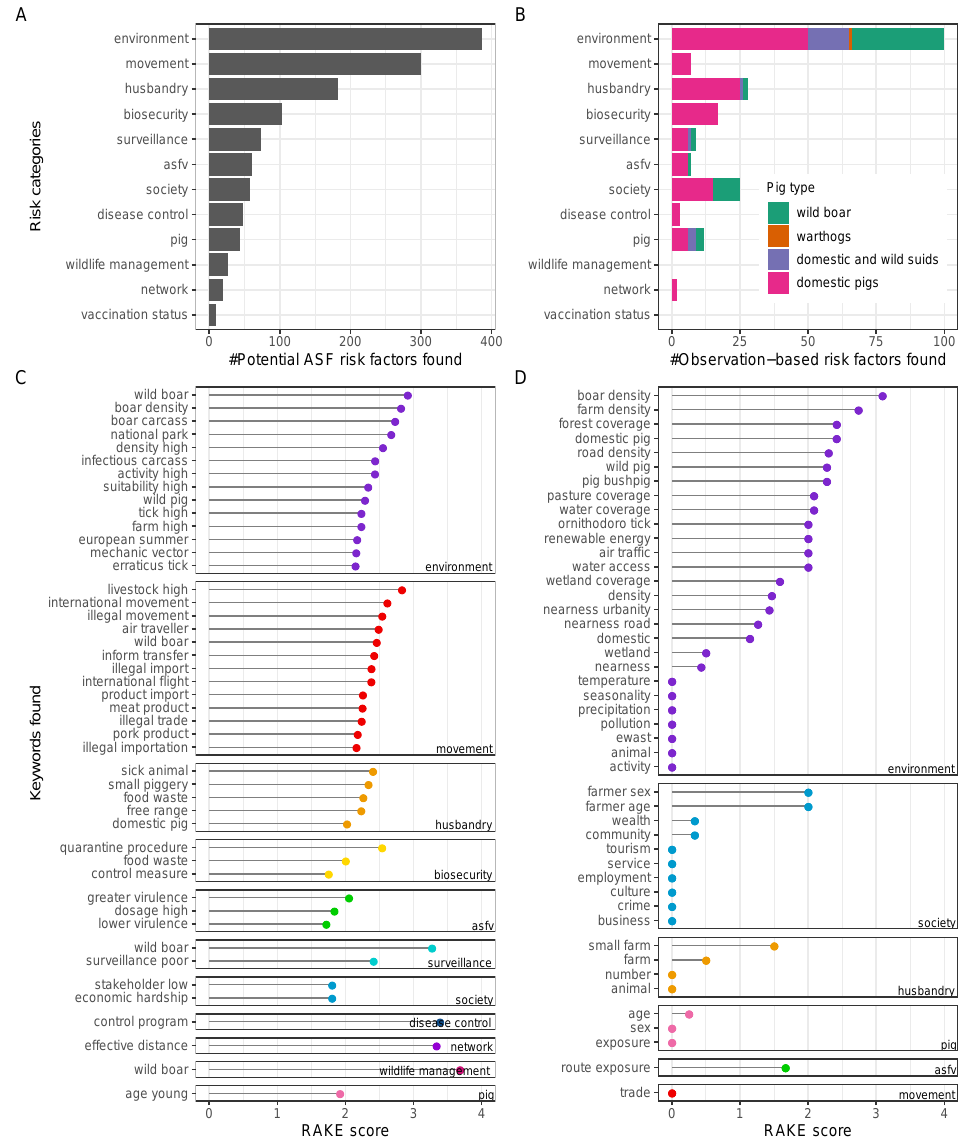
Figure 4. ASF risk factors. Enumeration of potential ASF risk factors ( A ) and observation-based ASF risk factors ( B ) by pig type and category. Keywords identified through RAKE among potential ( C ) and observation-based ( D ) risk factors. RAKE, Rapid Automatic Keyword Extraction Algorithm; ASFV, African swine fever